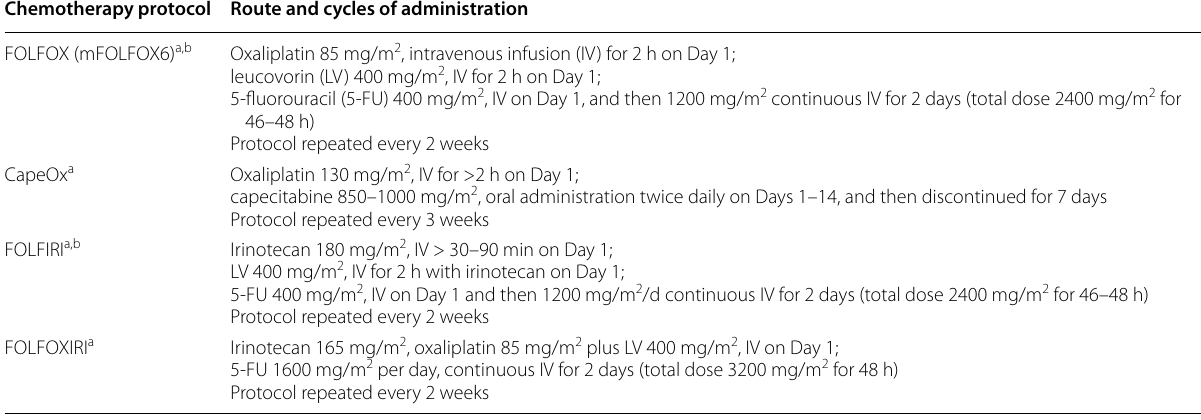
Table 1 First-line treatment protocols for patients with metastatic colorectal cancer (mCRC) who are able to tolerate highly intensified